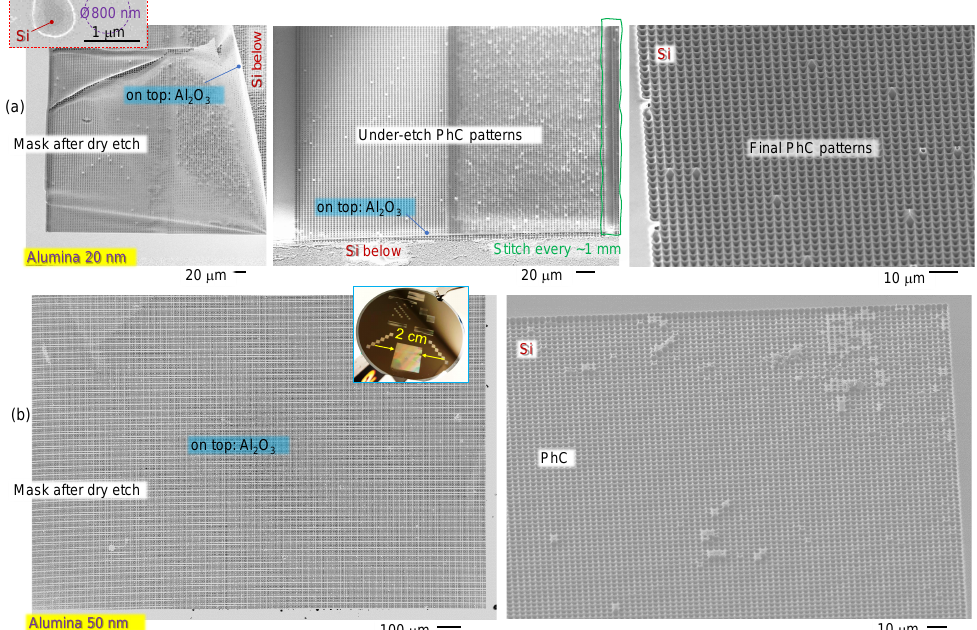
Figure 4. ( a ) SEM images of the Al 2 O 3 mask (20 nm) after plasma etching and the final PhC pattern on Si. The middle panel shows the implemented strategy to introduce a few µ m-wide bridges every 1 mm to prevent mask failure (left panel) due to under-etching. The pulse energy to open an ablation hole was E p = 12.5 nJ (on the sample). The inset shows the ablation opening in the mask, which matched exactly the focal diameter of 0.8 µ m (before etching) close to the focal diameter 1.22 λ / NA = 700 nm. ( b ) A mask of 50 nm of Al 2 O 3 (left image) maintained mechanical strength for the plasma etching over 1 × 1 cm 2 areas. Si patterned using a 50 nm alumina mask after ultra-sonic mask removal (right image). Etched by SF 6 :CHF 3 :O 2 at a 5:1:1 flow rate ratio for 10 min. The pulse energy to the open ablation hole was E p ≈ 12 nJ (on the sample). The inset shows the photo of the wafer-scale patterning tests used for the optimisation of the larger-area laser